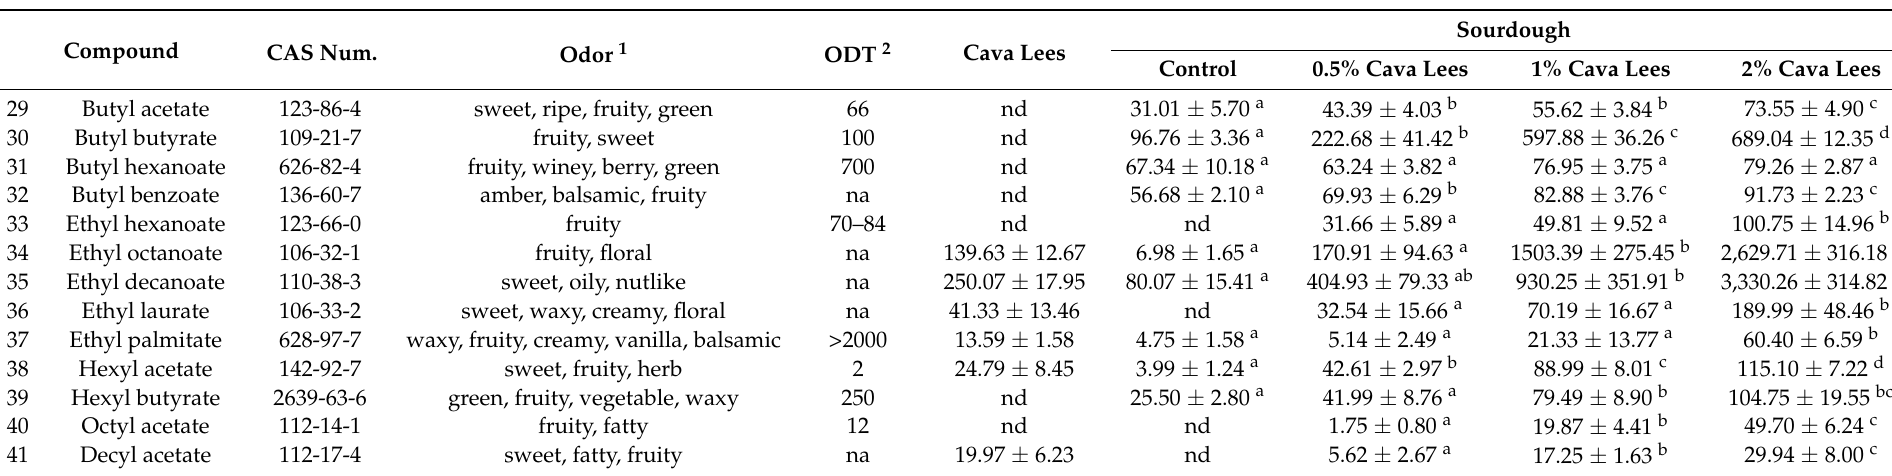
Table 5. Concentration (mg/kg) of major esters obtained with the optimized extraction parameters in Cava lees and